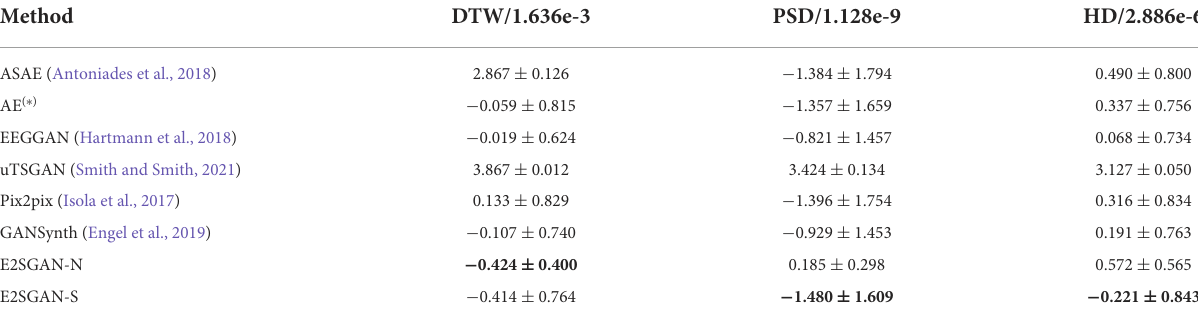
TABLE 2 Performance comparison with